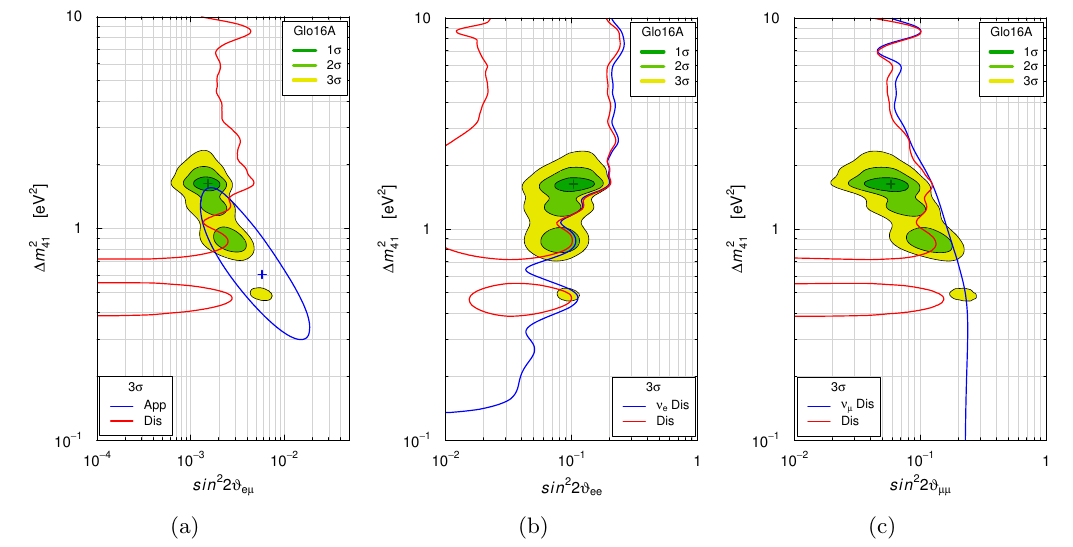
Figure 8 . Allowed regions in the sin 2 2 # e(cid:22) {(cid:1) m 2 (a), sin 2 2 # ee {(cid:1) m 2 (b), and sin 2 2 # (cid:22)(cid:22) {(cid:1) m 2 41 41 41 (c) planes obtained in the 3+1 global (cid:12)t \Glo16A" of the 2016 SBL data without the MINOS [35] and IceCube [36] data. There is a comparison with the 3 (cid:27) allowed regions obtained from ( (cid:0) ) (cid:23) (cid:22) ! ( (cid:0) ) (cid:23) e SBL appearance data (App) and the 3 (cid:27) constraints obtained from ( (cid:0) ) (cid:23) e SBL disappearance data ( (cid:23) e Dis), ( (cid:0) ) (cid:23) (cid:22) SBL disappearance data ( (cid:23) (cid:22) Dis) and the combined ( (cid:0) ) (cid:23) e and ( (cid:0) ) (cid:23) (cid:22) SBL disappearance data (Dis). The best-(cid:12)t points of the Glo16A and App (cid:12)ts are indicated by